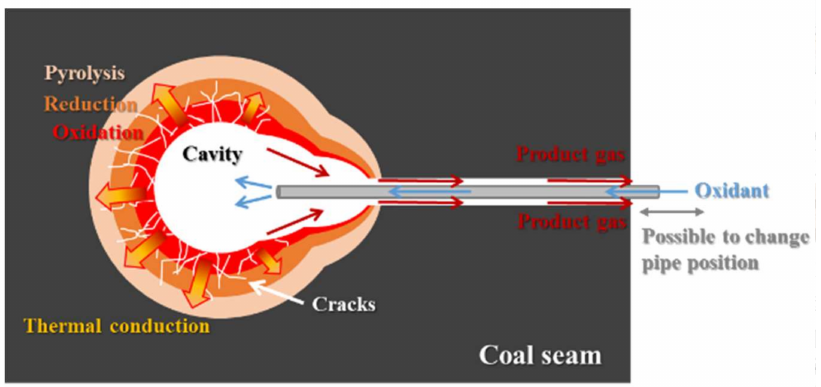
Figure 3. Coaxial UCG system with a horizontal